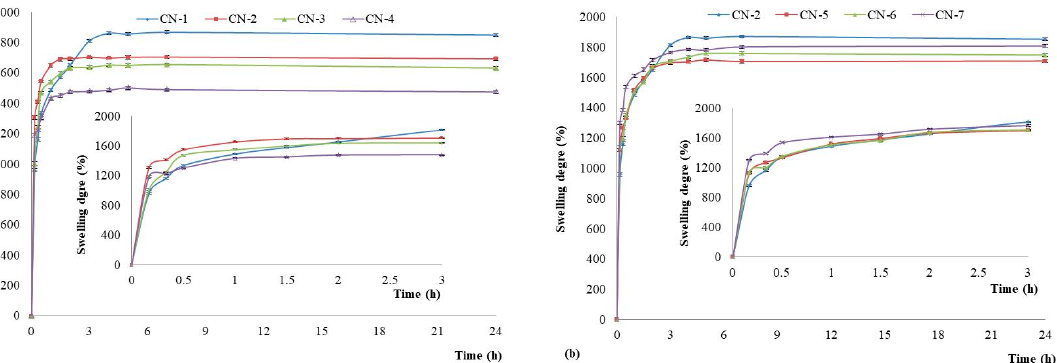
Figure 6. The swelling kinetics curves of the NCs in alkaline conditions (pH = 7.4) for samples ( a ) ( a ) CN-1, CN-2, CN-3, and CN-4; ( b ) CN-2, CN-5, CN-6, and CN-1, CN-2, CN-3, and CN-4; ( b ) CN-2, CN-5, CN-6, and CN-7.